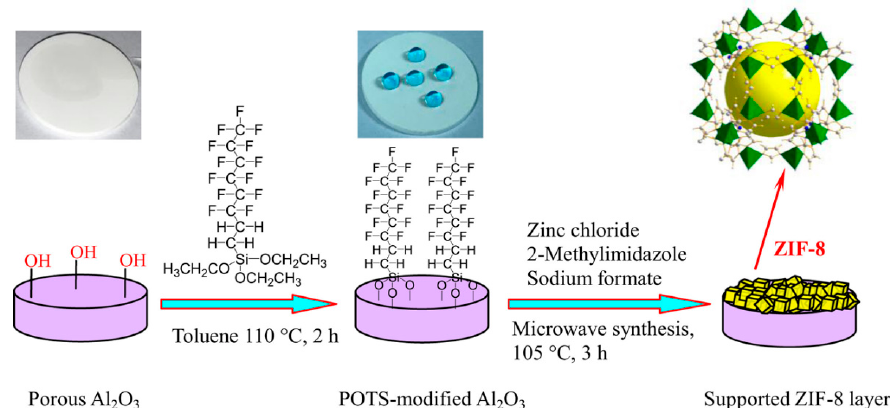
Figure 20. Scheme of the preparation of ZIF-8 membranes on hydrophobic α -Al 2 O 3 supports through 1H,1H,2H,2H-perfluoroalkyltriethoxysilanes (POTS) modification (adapted with permission from ref. [121]).